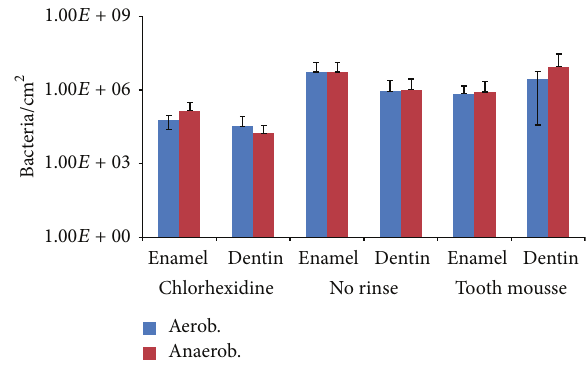
Figure 4: Quantification of colony forming units (CFU) after desorption for determination of adherent aerobic and anaerobic bacteria. Exposure of the specimens at the buccal sites of the upper 1st and 2nd premolar and 1st molar for 8h overnight MV ± SD, 𝑛 = 8 subjects, 2 samples per subject and preparation.